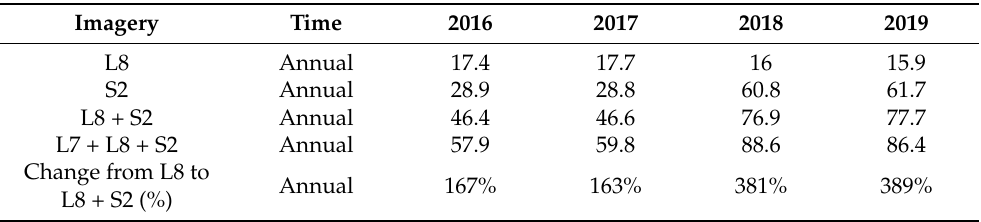
Table 2. Average count of annual clear-sky observations across the study area by sources of imagery.